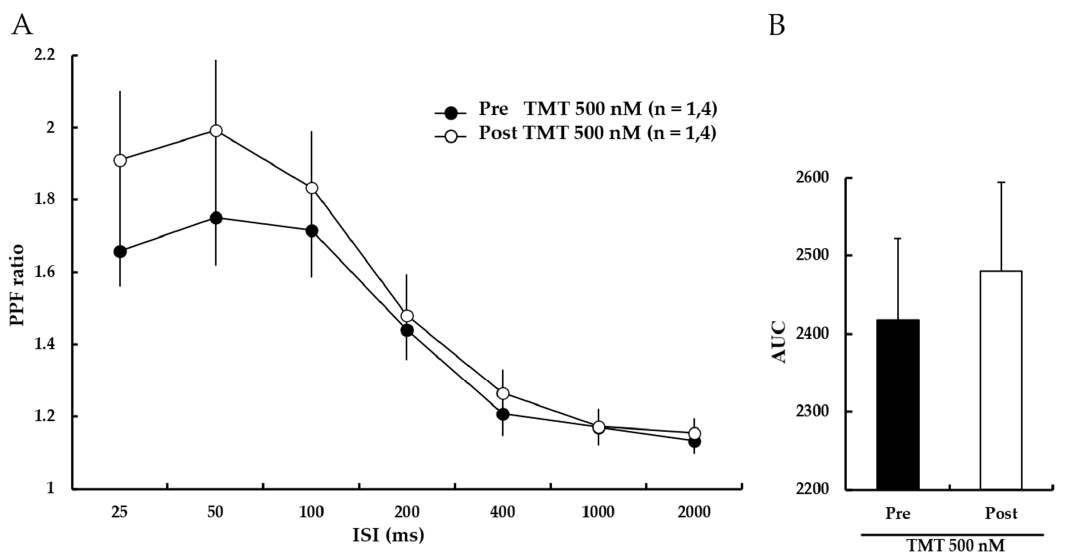
Figure 7. TMT (500 nM) does not affect the PPF ratio. ( A ) PPF ratios were similar before and after TMT (500 nM) perfusion. Filled circles and open circles indicate the Pre-500 nM TMT group and Post-500 nM TMT group, respectively. ( B ) The AUCs for the PPF ratio were not significantly different. Statistical significance (Post-TMT group vs. Pre-TMT group) was calculated by Student’s t -test. ISI: interstimulus interval, AUC: area under the curve.